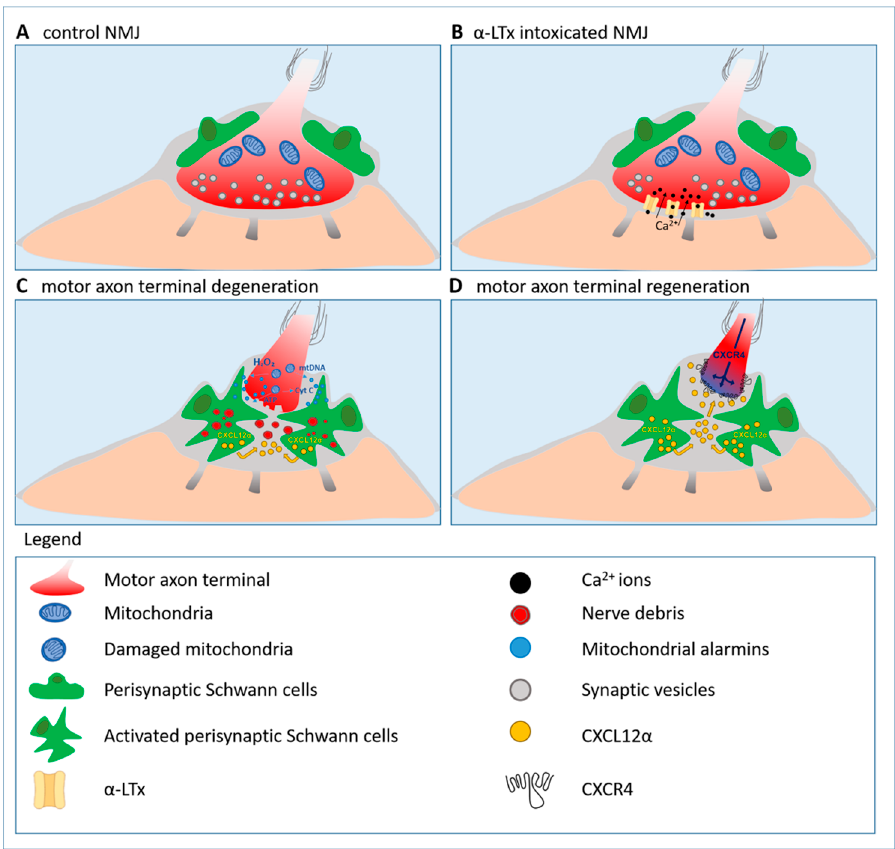
Figure 2. Motor axon terminal regeneration at the murine neuromuscular junction (NMJ) following the acute and reversible injury by the pore-forming toxin α -Latrotoxin ( α -LTx). Neuronal alarm signals, mainly of mitochondrial origin, such as H 2 O 2 , cytochrome c, mitochondrial DNA (mtDNA), and ATP (blue spots), trigger perisynaptic Schwann cells (PSC) (green) activation. Activated PSC phagocytose nerve debris (red), and release the chemokine CXCL12 α (yellow) which, by interacting with CXCR4 re-expressed by the motor axon stump, promotes motor axon elongation and, in turn, NMJ functional restoration (adapted from [103]).